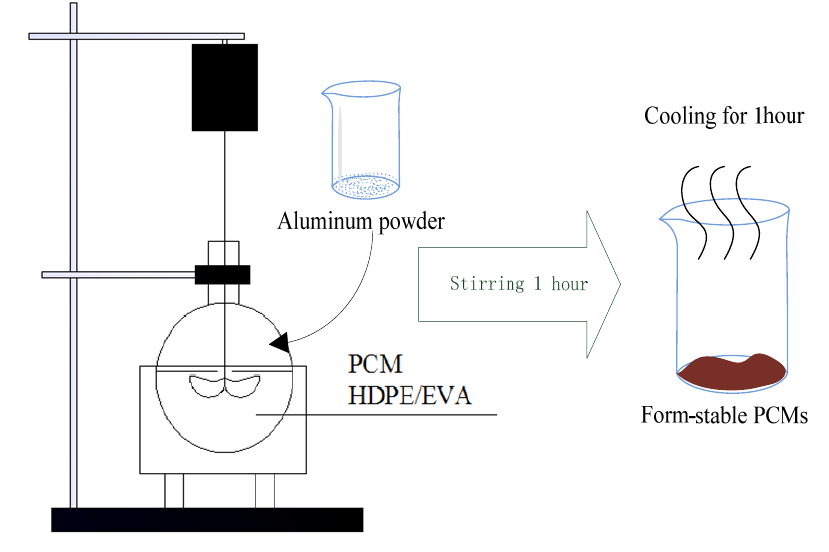
Figure 1. The preparation process of form-stable phase change materials (PCMs) by fusion method.